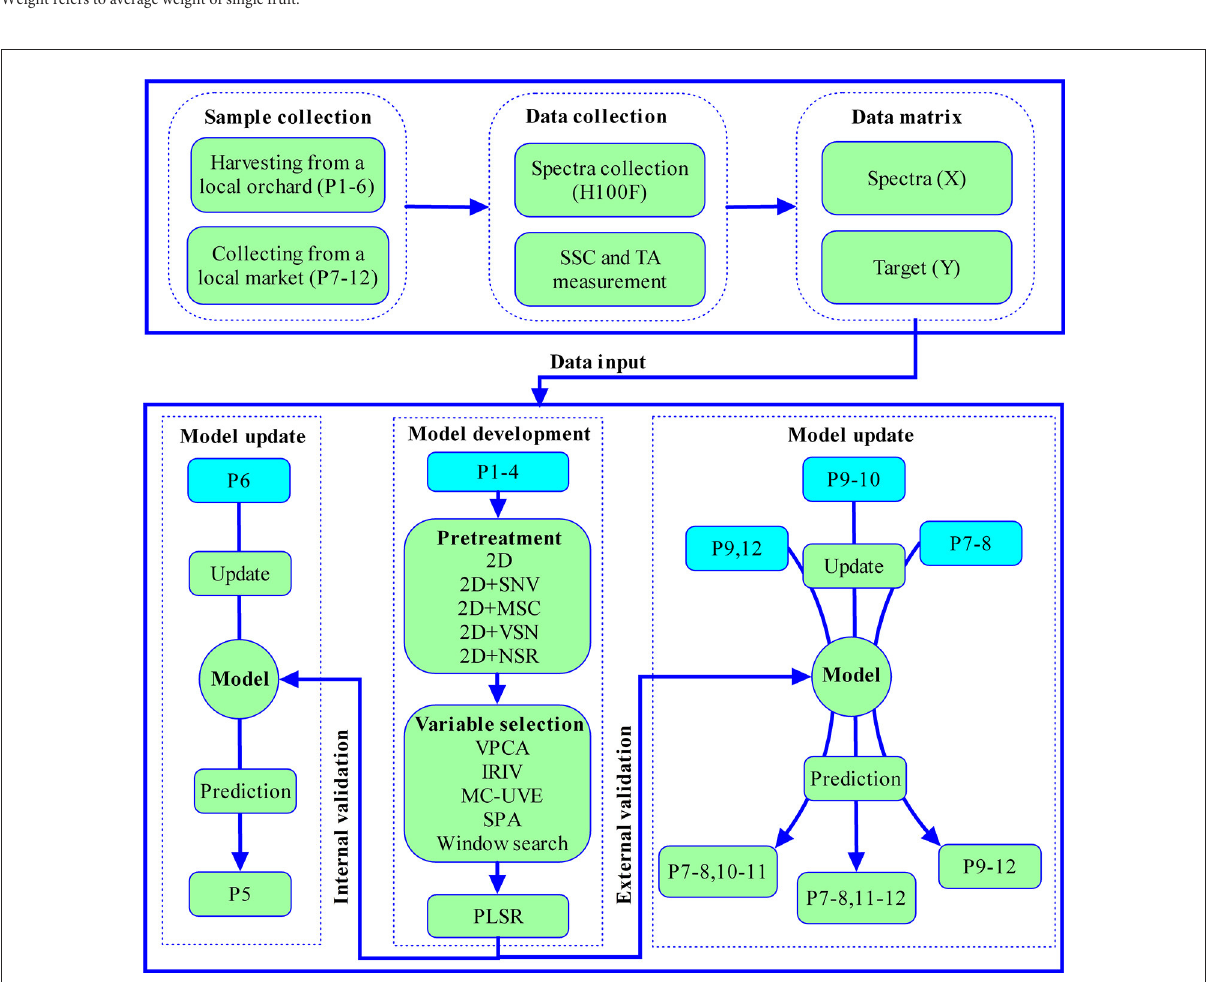
FIGURE1 Flowchart of all experimental procedures, P represented